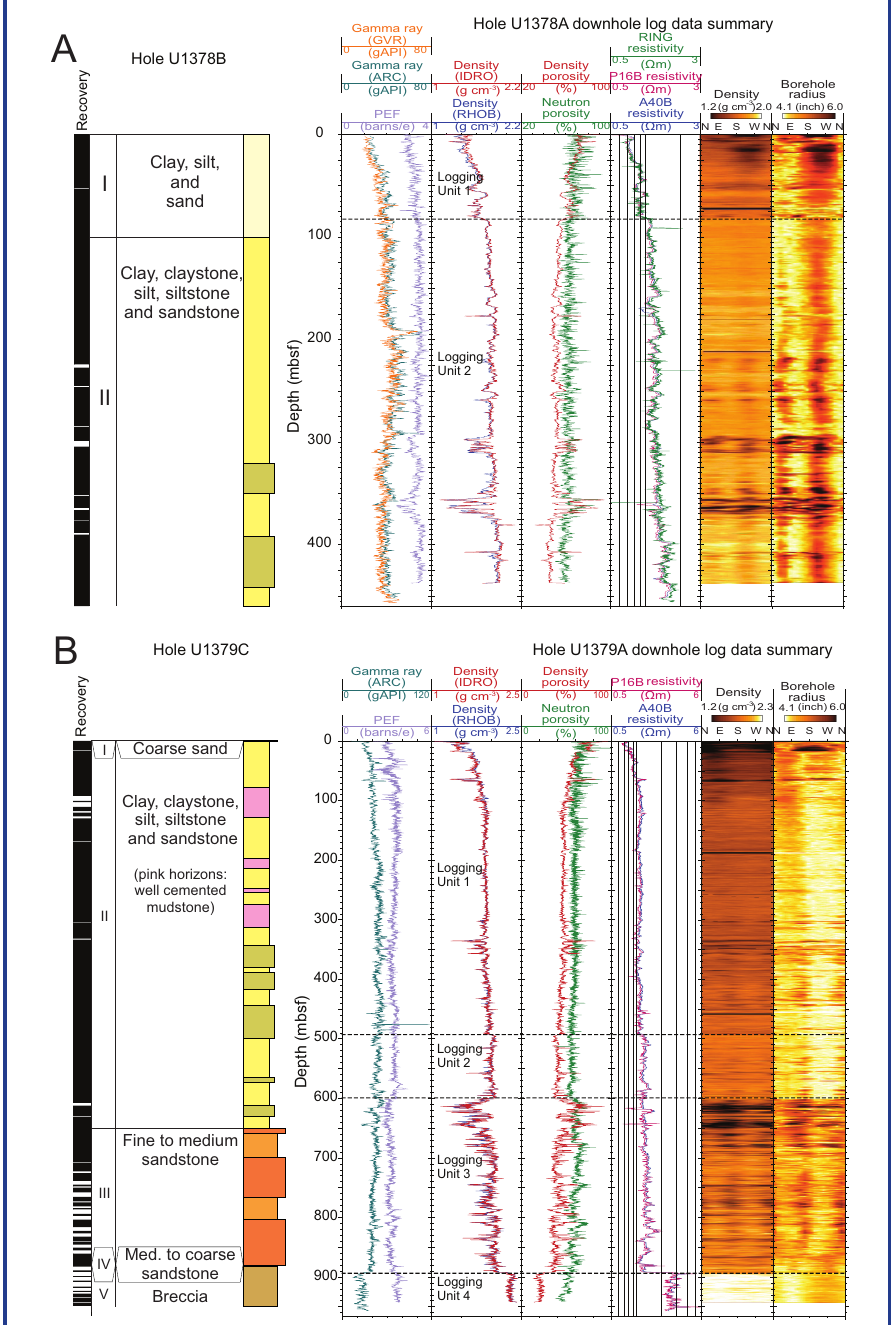
Figure 5. Summary of the lithostratigraphy and LWD measurements. [A] is for Site U1378, [B] for Site 1379C. GVR=geoVISION tool, ARC=arcVISION tool, PEF=photoelectric factor, IDRO=image-derived density (EcoScope tool), RHOB=bulk density, RING=resistivity measured by the ring electrode (geoVISION tool), P16B=phase-shift resistivity measured at a 16-inch source-receiver separation (arcVISION tool), A40B=attenuation resistivity measured at a 40-inch source-receiver separation (arcVISION